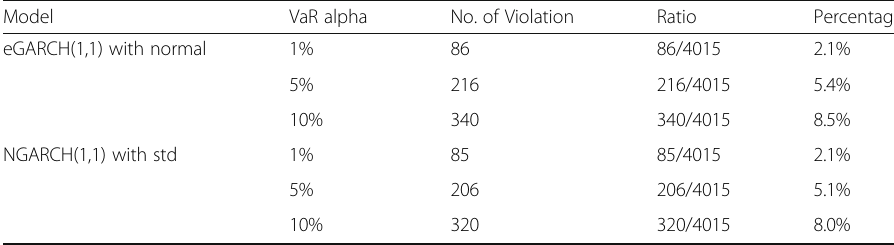
Table 7 VaR violation of the actual Total Nigeria Plc returns Model VaR alpha No. of Violation Ratio eGARCH(1,1) with normal